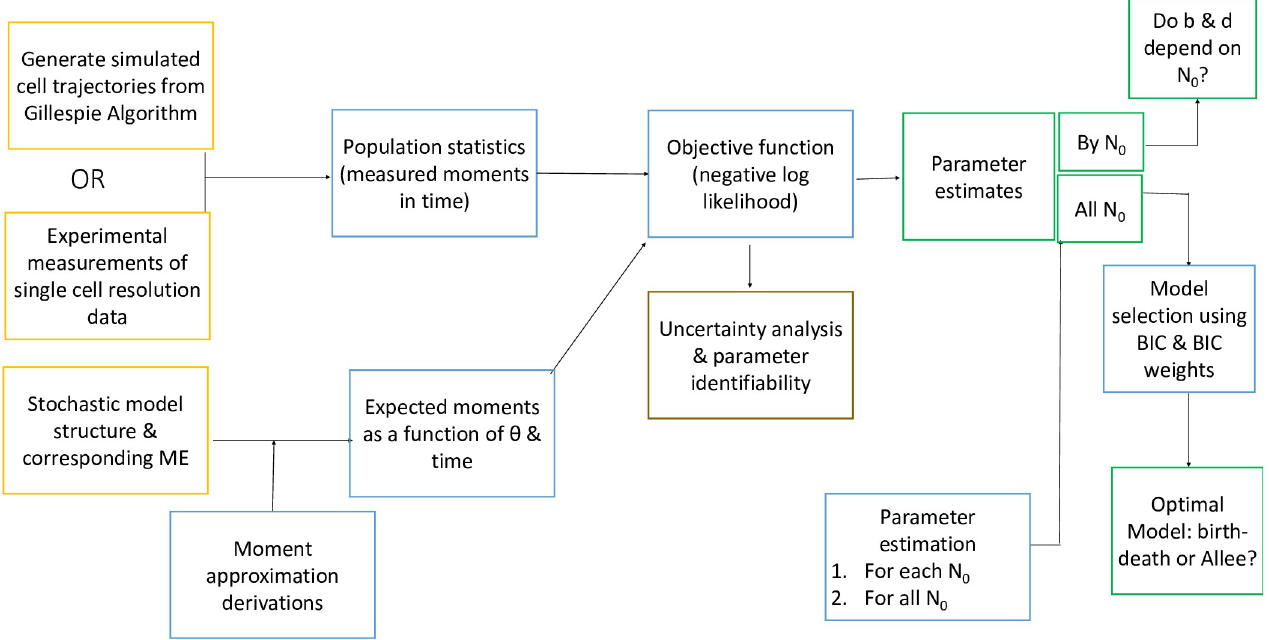
Fig 3. Moment-closure approximation approach for stochastic parameter estimation. Framework for moment-closure approximation approach to derive moments from the ME of a stochastic process and how model expected moments are fit to stochastic data. BIC, Bayesian Information Criterion, ME, master